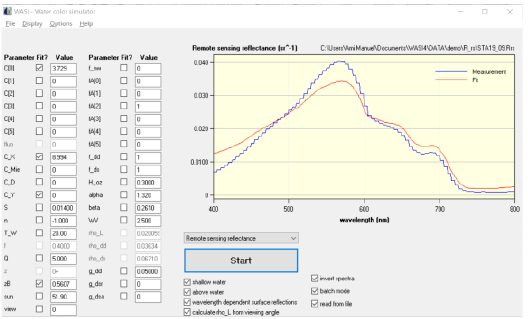
Figure 3. Spectral inversion interface of WASI- Water color simulator